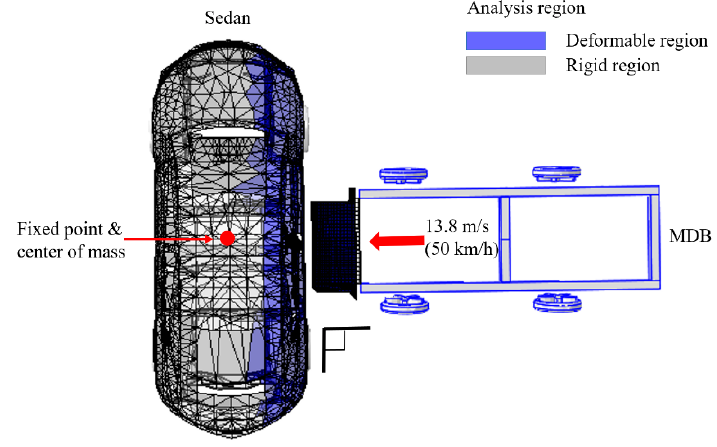
Figure 6. Boundary conditions for side crash simulation. Table 4. Collision conditions for side crash simulation.